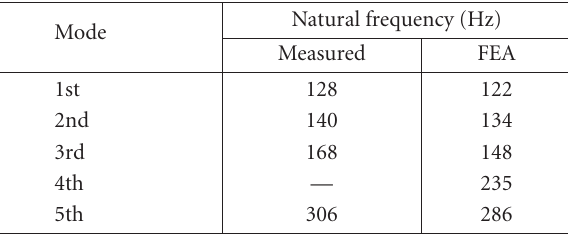
Table 3: Comparison of natural frequencies by FEA with excitation test of the fan-shaft